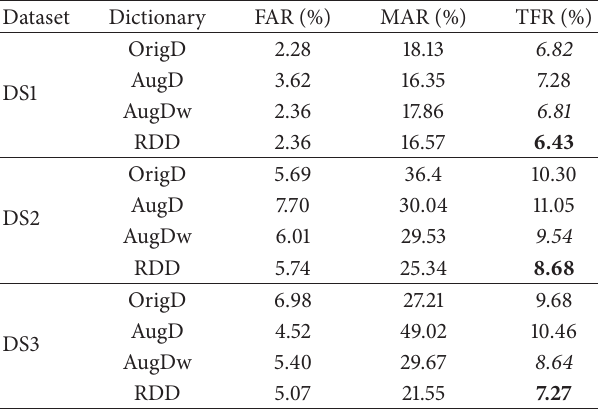
Table 4: Performance comparison of different